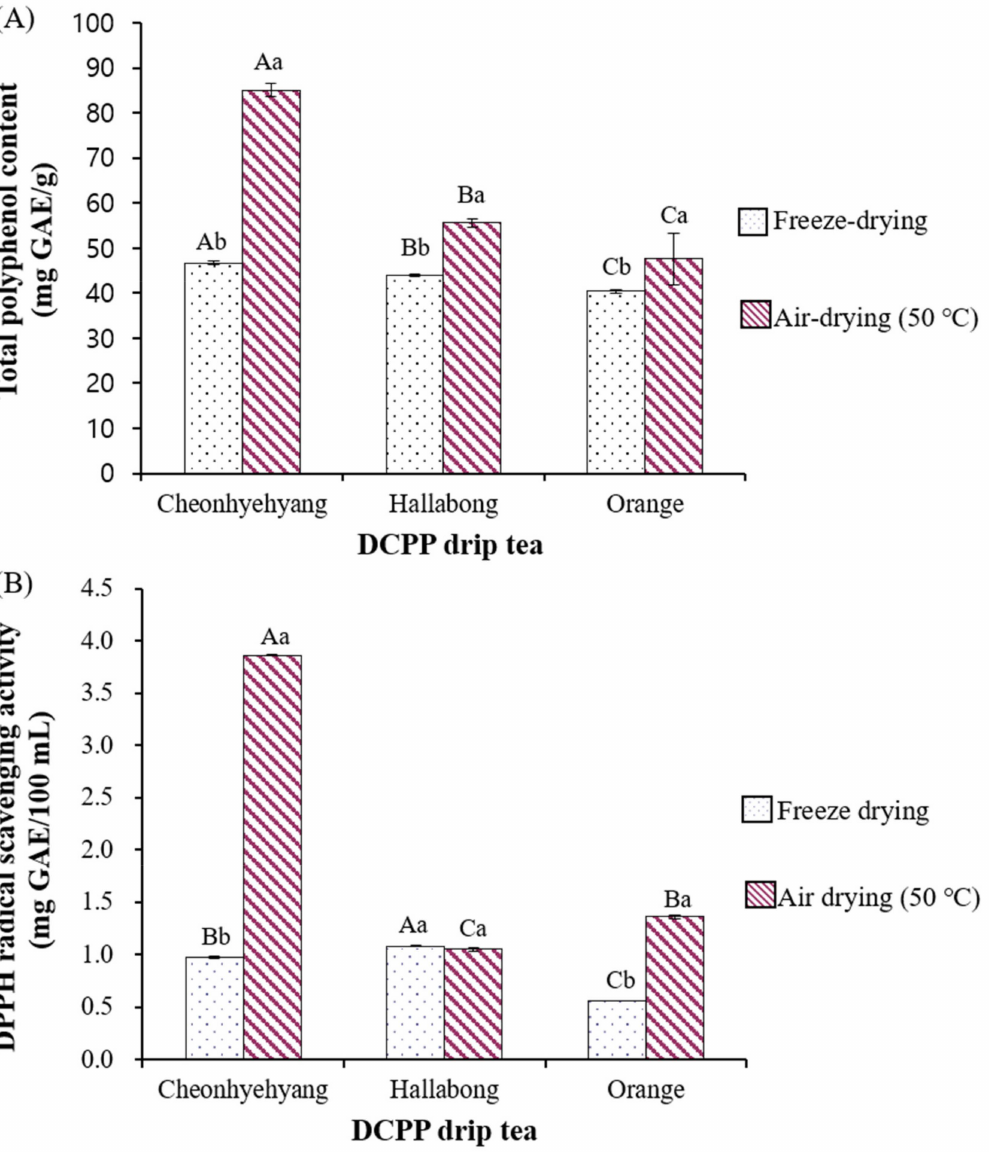
Figure 2. The total polyphenol contents and DPPH radical scavenging activity of machine-drip tea prepared from DCPP. ( A ) Total polyphenol contents, ( B ) DPPH radical scavenging activity). DCPP Dried citrus peel powder. Means with different capital letters in the same column for each color parameter were significantly different by Duncan’s multiple range test ( p < 0.05, A > B > C). Means with different small letters on the same row were significantly different by t -test ( p < 0.05, a > b). The highest TPC was observed in air-dried Cheonhyehyang tea (85.12 mg GAE/100 mL), followed by air-dried Hallabong tea (55.61 mg GAE/100 mL) and air-dried orange tea (47.63 mg GAE/100 mL). In addition, Cheonhyehyang DCPP tea had about an 82% dif- ference, whereas orange DCPP had just a 20% difference in TPC for the drying method. Cheonhyehyang peel was considered more susceptible to air-drying than other citrus